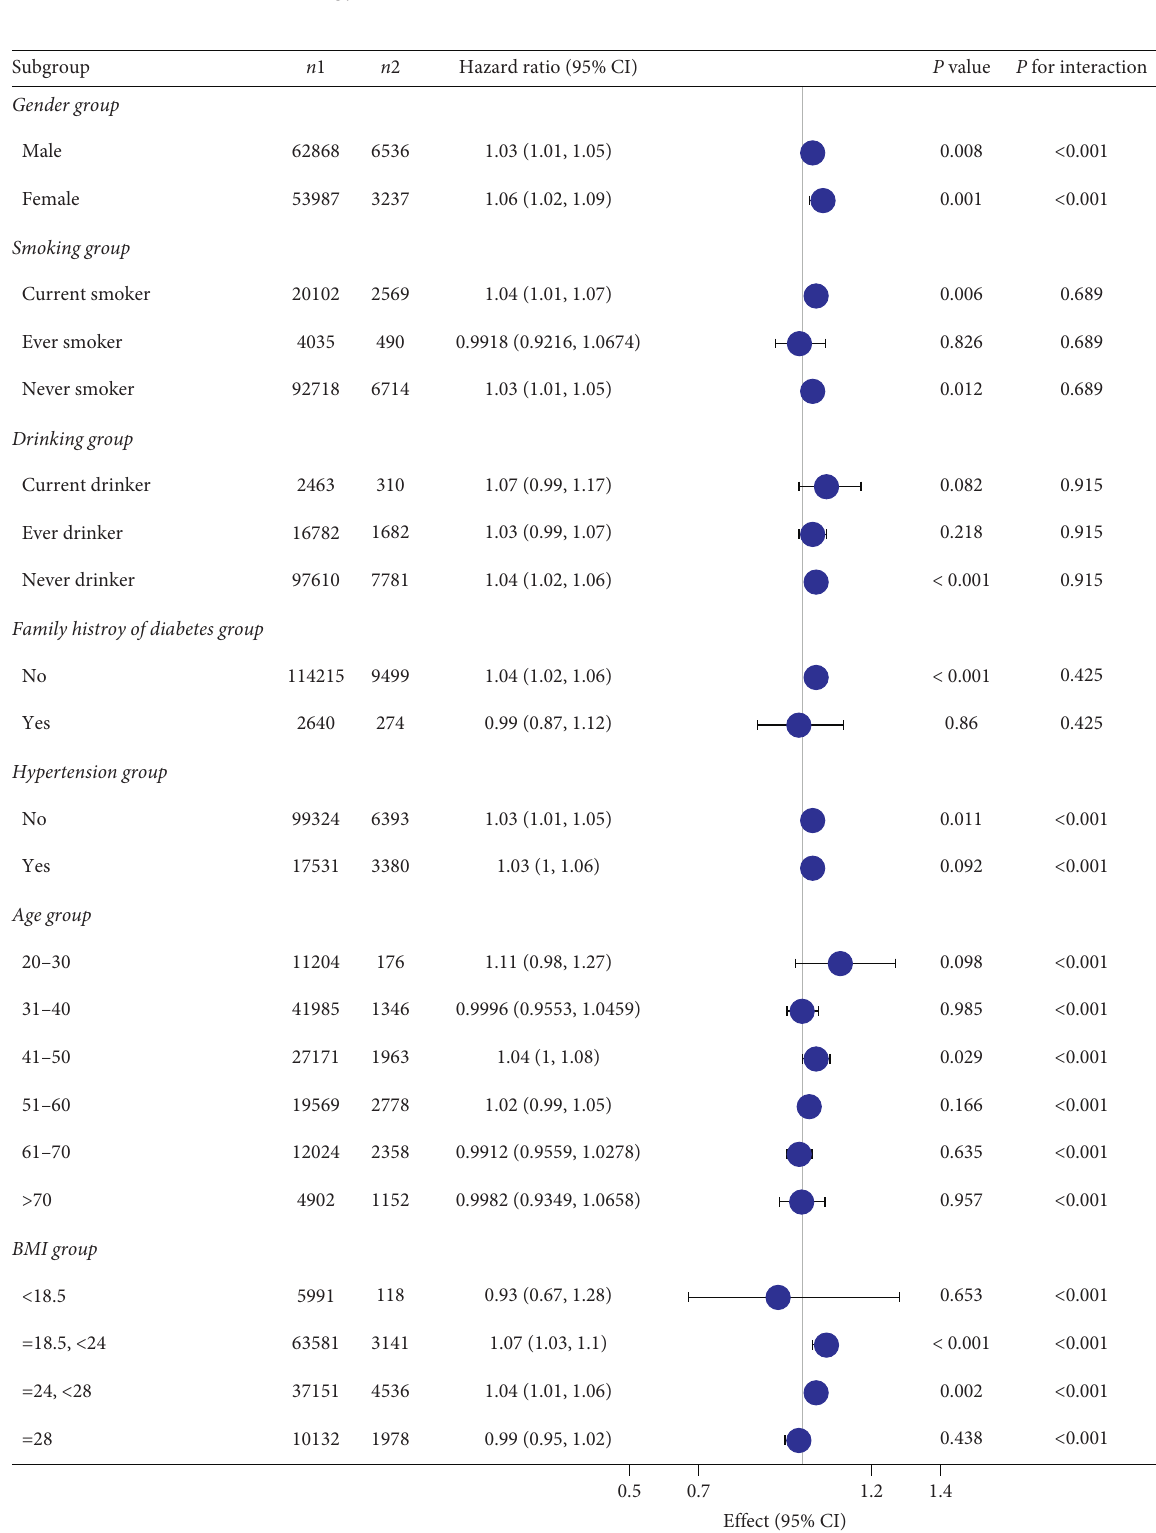
Figure 6: Subgroup analysis of the association between TG/HDL and impaired glucose